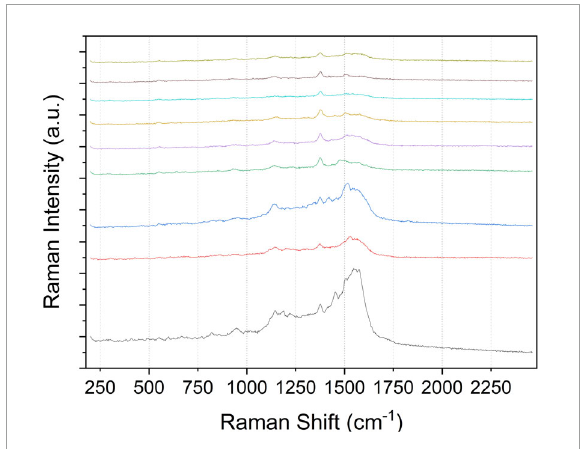
FIGURE6 The spectrum after preprocessing the original Raman spectrum by subtracting the baseline,